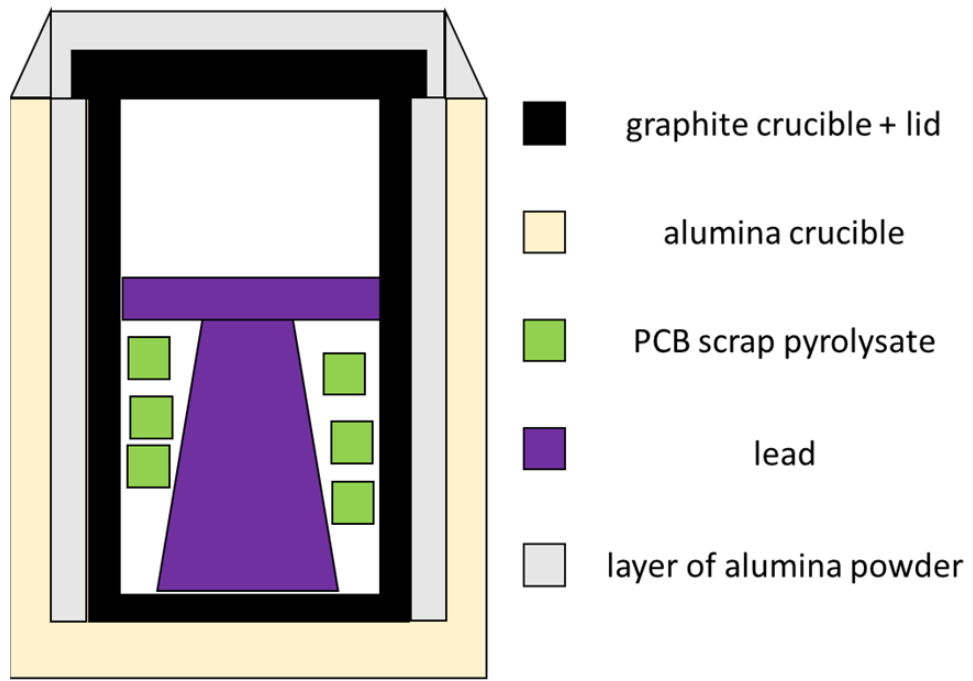
Figure 4. Scheme of the system cross-section of materials before PCB scrap melting with lead .